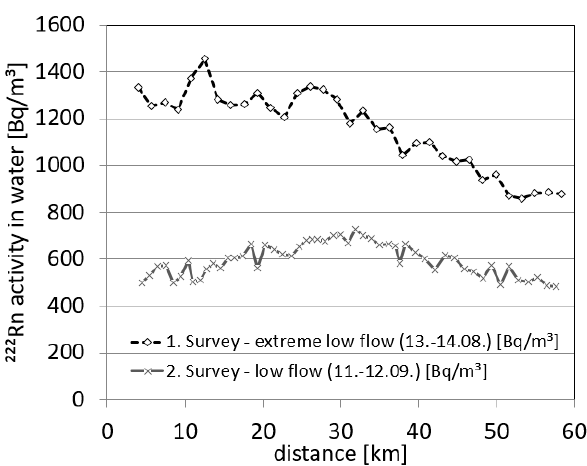
Figure 7. 222 Rn concentration [Bq/m³] in the river water between Schmilka (km 0) and Pieschen (km 60) as detected from the cruising vessel during the two surveys.